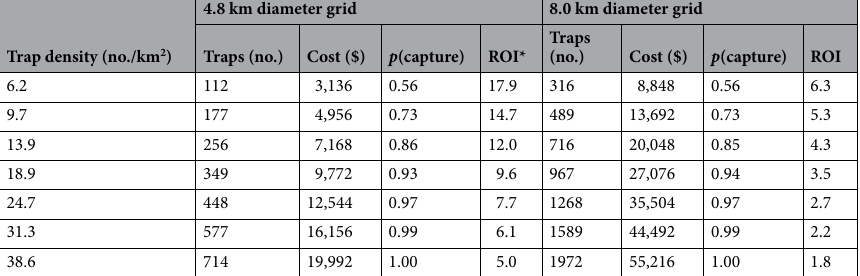
Trap density (no./km 2